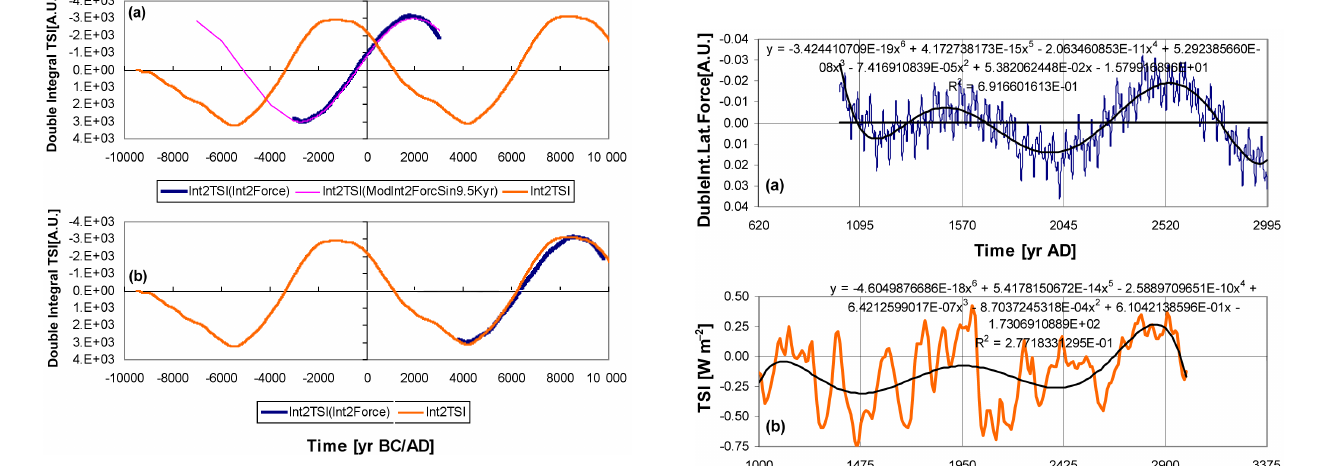
Figure B3. A comparison of the double integral of the solar re- constructed and extrapolated record σT 2 ( t ) and the model based on solar lateral inertial forces, σF 2 ( t ), σT 2 ( t ) [ σF 2 ( t )]. To en- hance a possible cause–effect relationship [ σF 2 ( t )– σT 2 ( t )] the σT 2 ( t ) [ σF 2 ( t )] record is shown (a) without and (b) with a lag of 6700 years. Vertical scale of values were inverted because the dou- ble integral procedure changes the sign of the enhanced result, thus upper/lower values indicate maxima/minima.